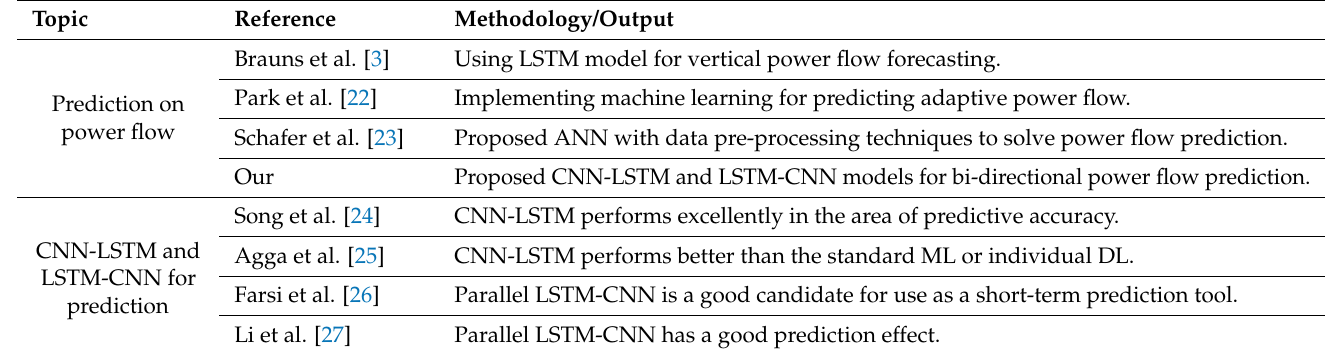
Table 1. Summary of related